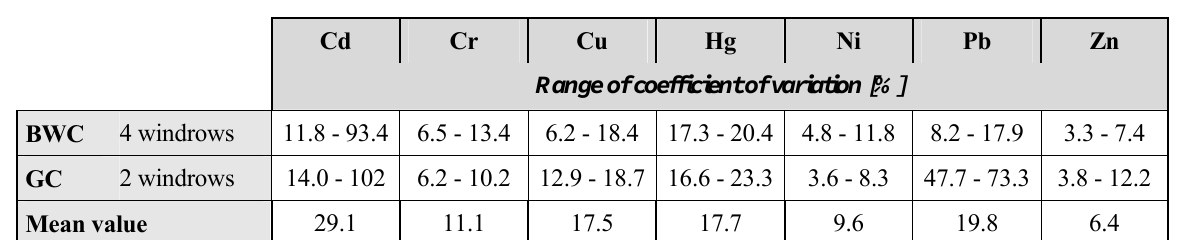
Spatial variability [coefficient of variation/CV] of heavy metal contents within a sampled compost heap Breuer et al. (1997 [FA5]